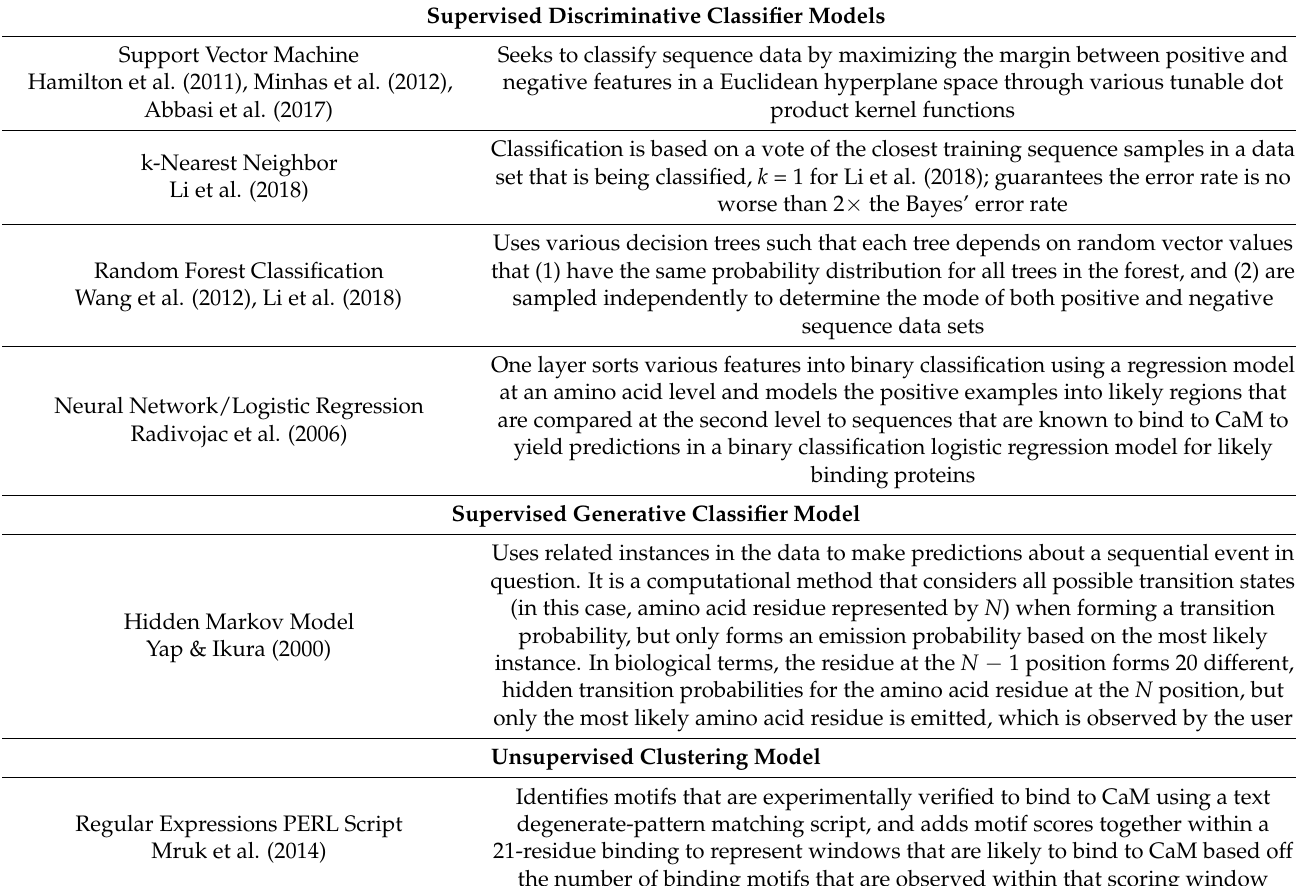
Table 2. CaM-Binding Prediction